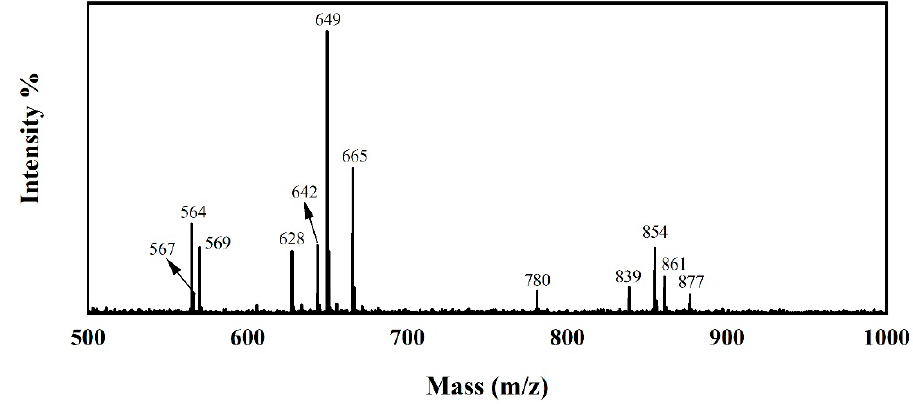
Figure 14. The MS spectra of the friction-tested steel plates lubricated by the 2 wt.% JD2000 aque- ous solution. ous solution.